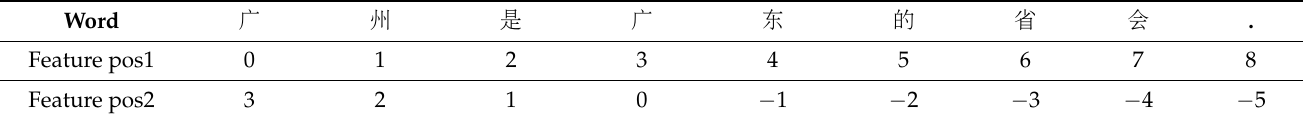
Table 1. Instance of relative entity